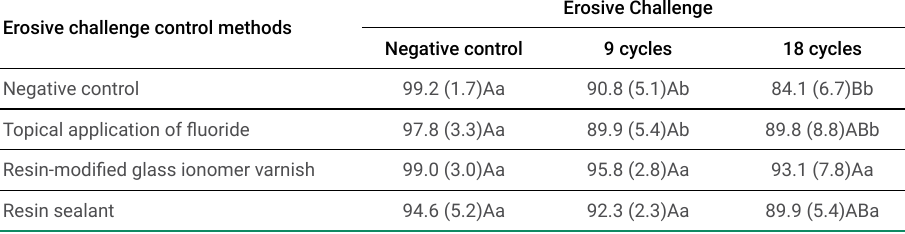
Table 1. Mean (standard deviation) of experimental groups – External margin